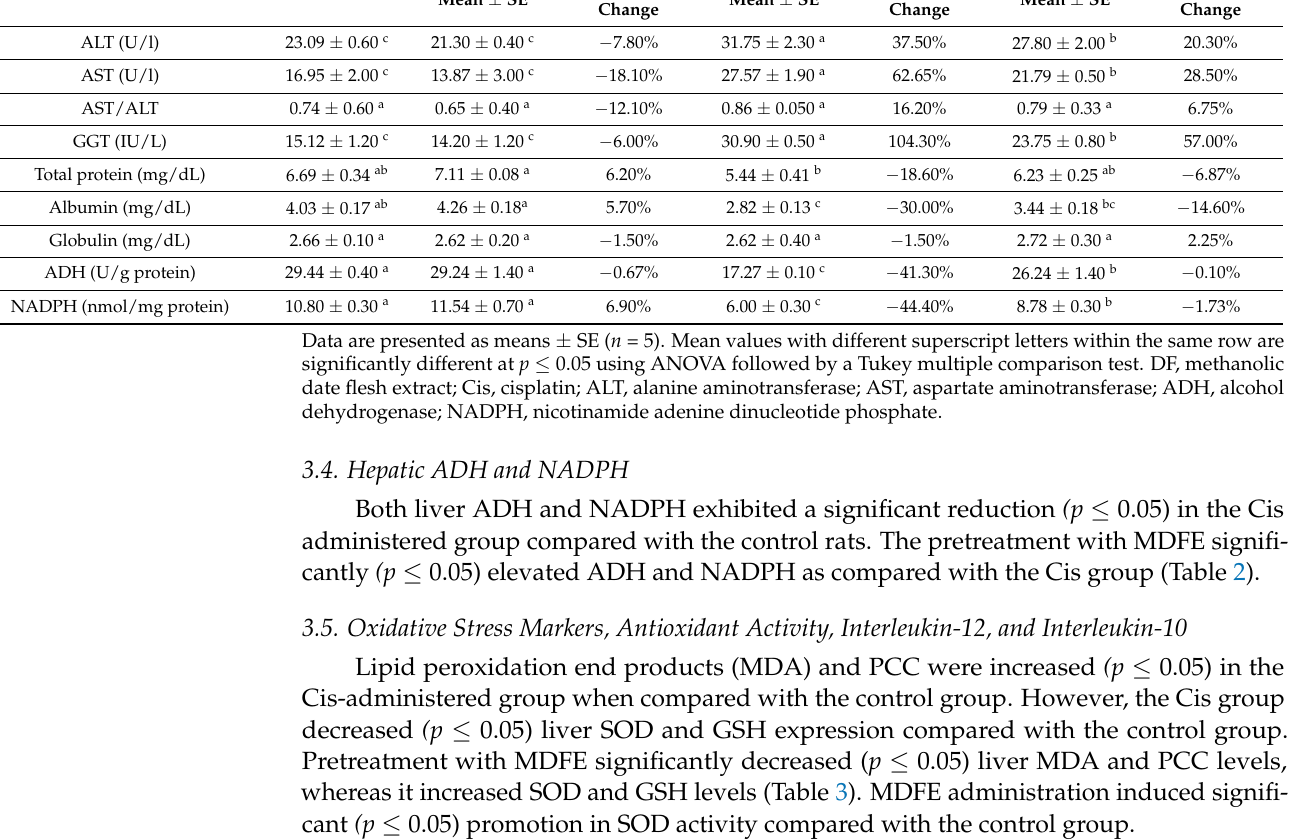
Table 3. Effect of pretreatment with methanolic date flesh extract (MDFE) on the liver protein carbonyl content (PCC), malondialdehyde (MDA), superoxide dismutase (SOD), reduced glutathione